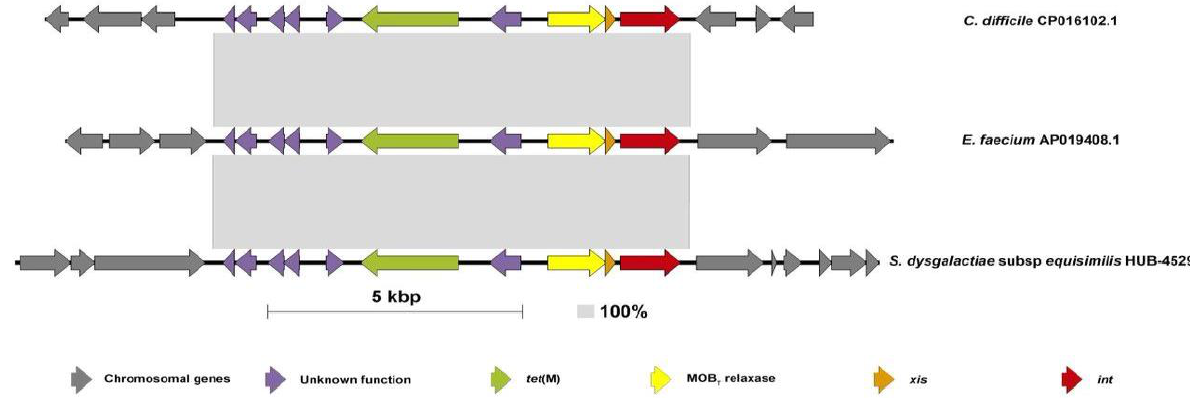
Figure 2. Schematic representation of the IME containing tet (M) in the SDSE compared with the sequence from E. faecium and C. difficile . This figure shows the structure of the IME containing the tet (M) gene found in twelve strains of the present study (HUB, HUD, HGUGM) compared with the previously described isolates in the literature for E. faecium (Acc. num AP019408.1) and C. difficile (Acc. num CP016102.1). The size of this IME is 9352 bp. The grey-shaded areas connect identical regions (100% identity). Each arrow represents a gene. Colors represent different genes. Grey: chromosomal genes (compared in SDSE with reference strain (AC-2713) (Acc num HE858529.1)). Red: integrase; orange: excisionase; yellow: MOBT relaxase; green: tet (M) gene; purple: unknown function genes. Table 1. The antibiotic susceptibility of 24 tetracycline-resistant SDSE strains. Antibiotic